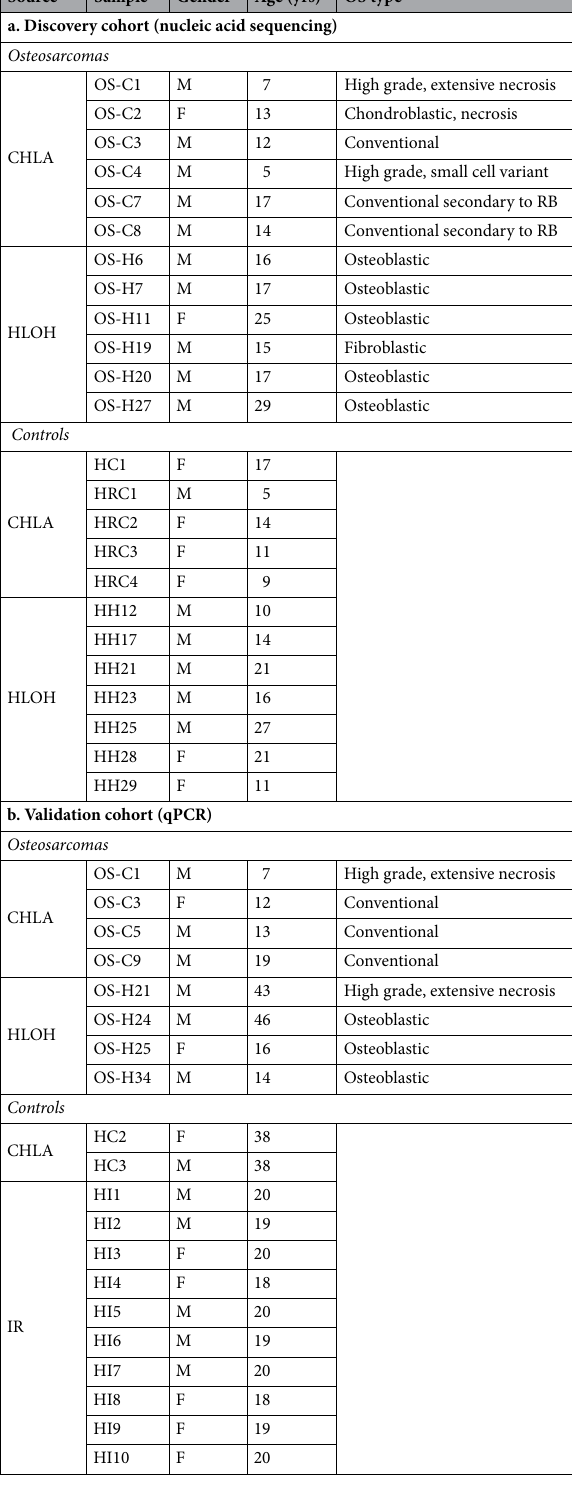
Table 1. Osteosarcoma patient and control donor characteristics. OS-C, osteosarcoma from CHLA; OS-H, osteosarcoma from HLOH; HC, healthy control from CHLA; HH, Healthy control from HLOH; HI, healthy control from Innovative Research Inc.; HRC, hereditary retinoblastoma sibling